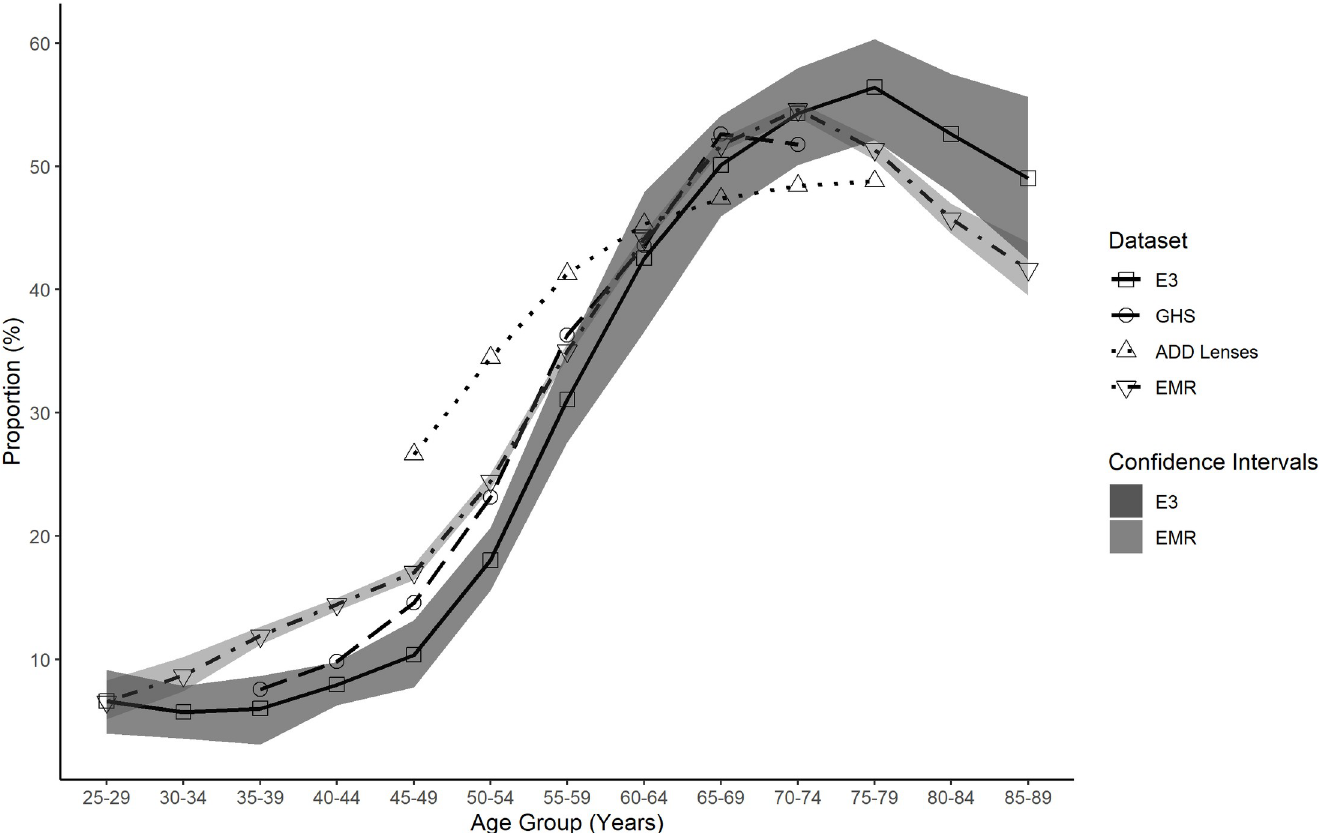
Fig 8. Total hyperopia proportion for all data sets as a function of age group. Total hyperopia proportion for EMR (inverted triangle), ADD Lenses (triangle), GHS (circle) and E3 (square) data as a function of age group. The E3 data confidence intervals (dark shaded area) are plotted to illustrate comparison with the other data sets. The EMR data confidence intervals (light shaded area) are plotted to show the overlap with the E3 data.